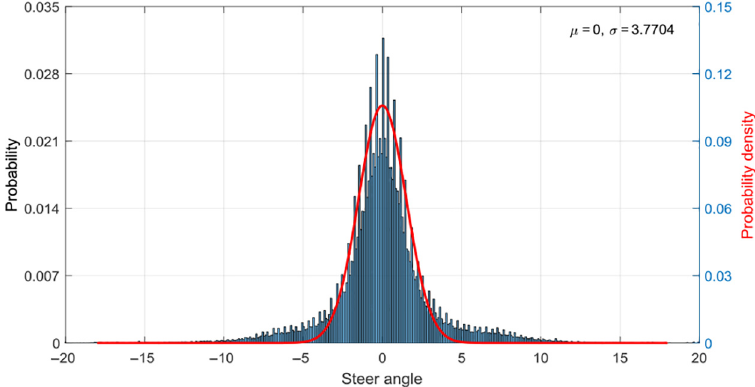
Figure 9 The distribution of turning-probability in highway section